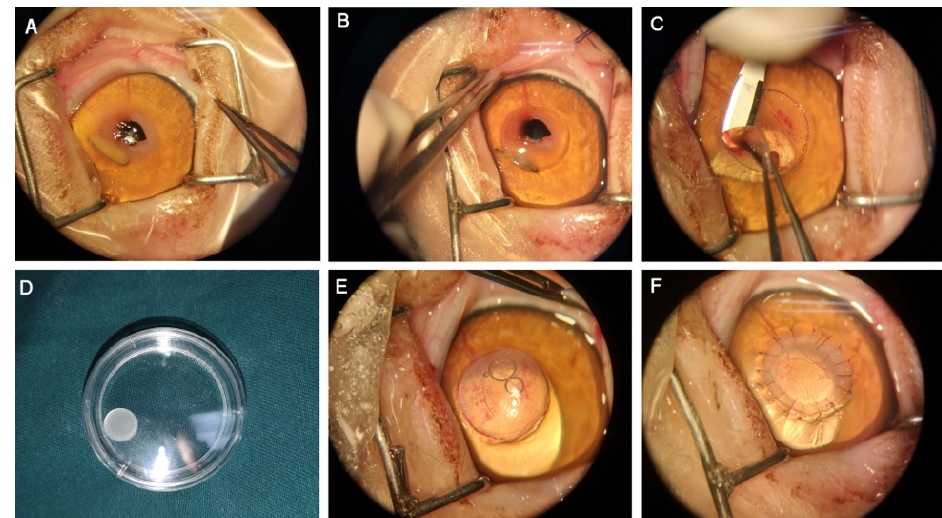
Figure 1. Surgical procedures of lamellar superficial keratectomy with BioCorneaVet TM (Case 1). ( A ) The affected eye was prepared for surgery and the sequestrum was measured; ( B ) A keratectomy was performed to the corneal sequestrum with a corneal trephine; ( C ) A crescent blade was used to completely remove the sequestrum; ( D ) An appropriate graft (400 microns thickness) was selected; ( E ) The graft was trephined to the appropriate diameter (7.50 mm); ( F ) The graft was positioned by simple interrupted absorbable sutures.